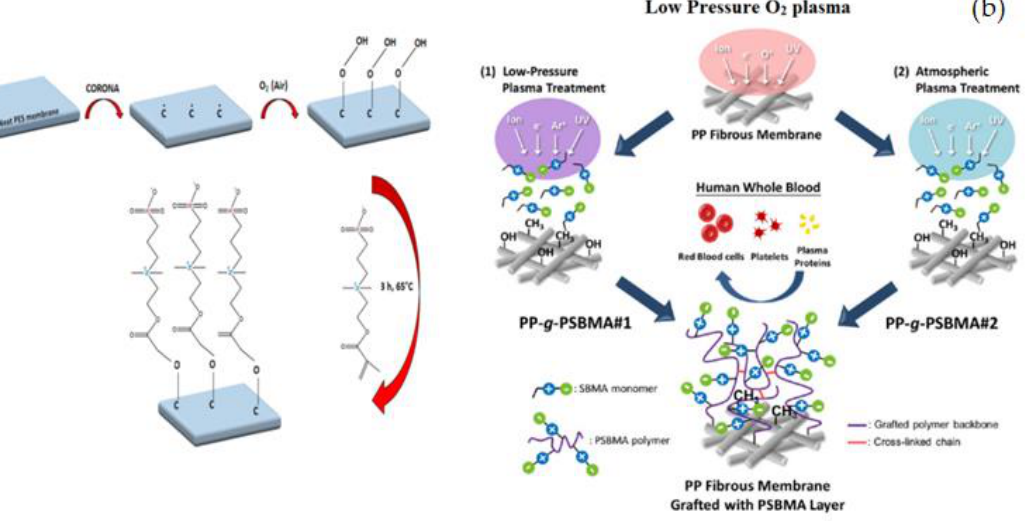
Figure 14. ( a ) ZW copolymerization process of PES membrane via corona air plasma [205], ( b ) Sche- matically synthesis of PSBMA-Grafted PP membranes using the low-pressure treatment and atmos- pheric plasma treatment [202].